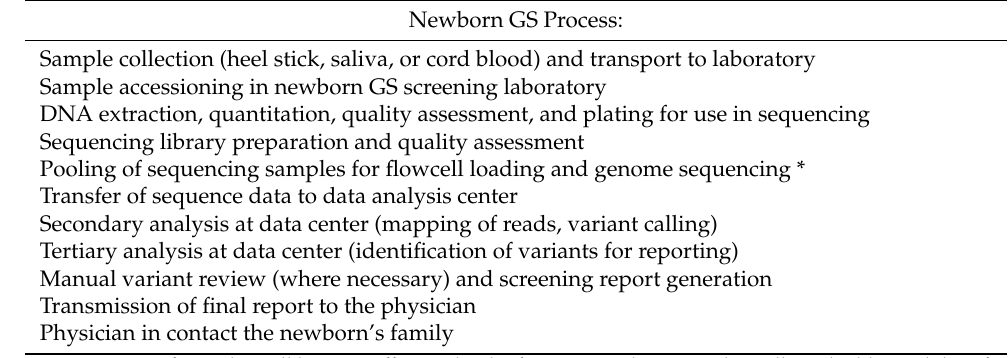
Table 2. Newborn genome sequencing (GS)